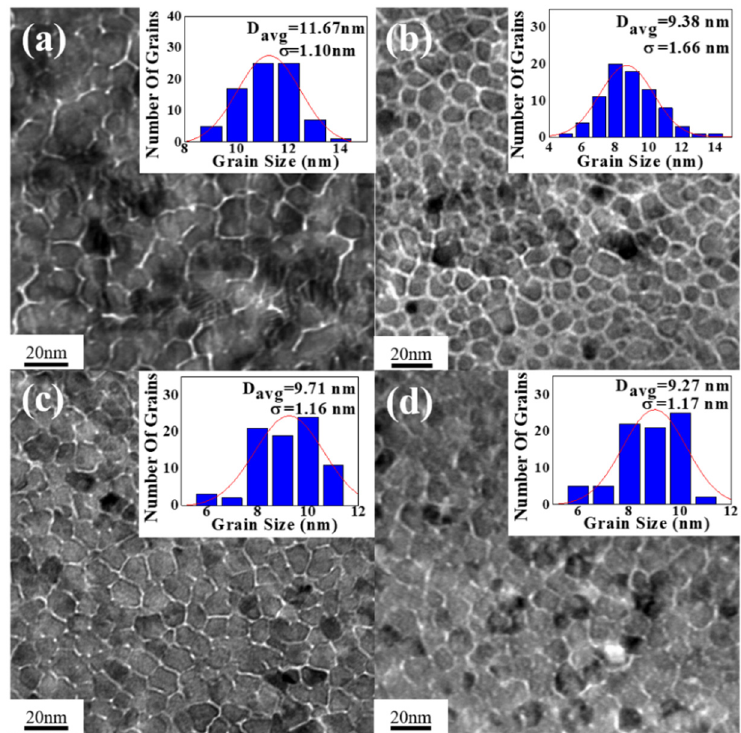
Figure 3. Plane view transmission electron microscopy (TEM) images of CoCrPt/y/NiW/NiTa, here y is (a) Ru, (b) RuCoCr, (c) RuCoCrTi, and (d) RuCoCrRe intermediate layer.